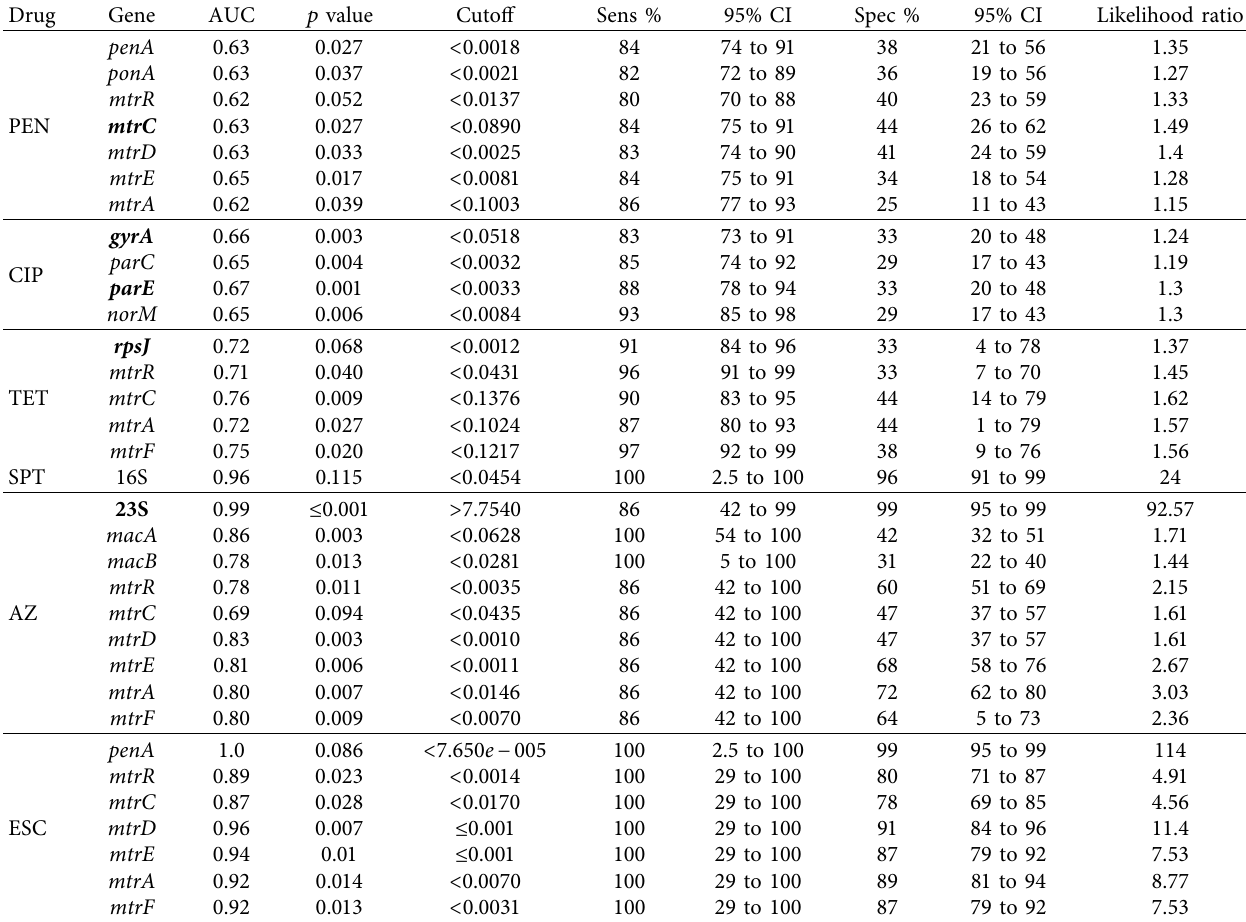
Table 3: Diagnostic performance of AMR-associated genes to detect antibiotic resistance using cutoff values determined by ROC analysis.